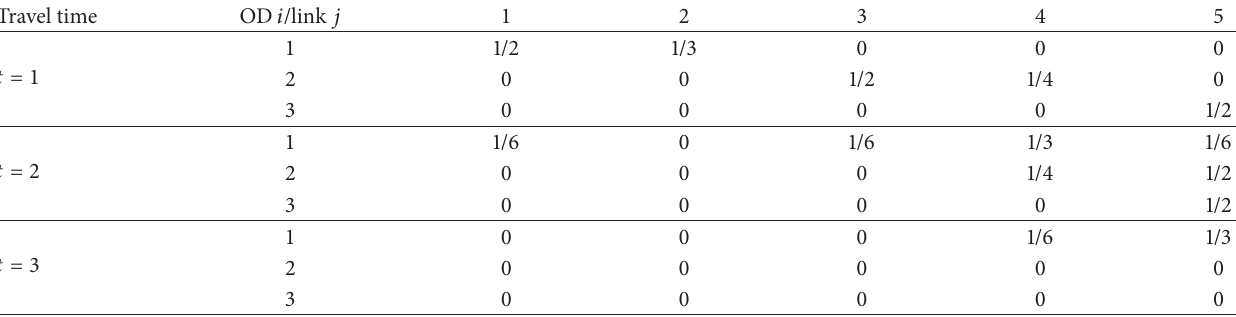
Table 8: Assignment matrix